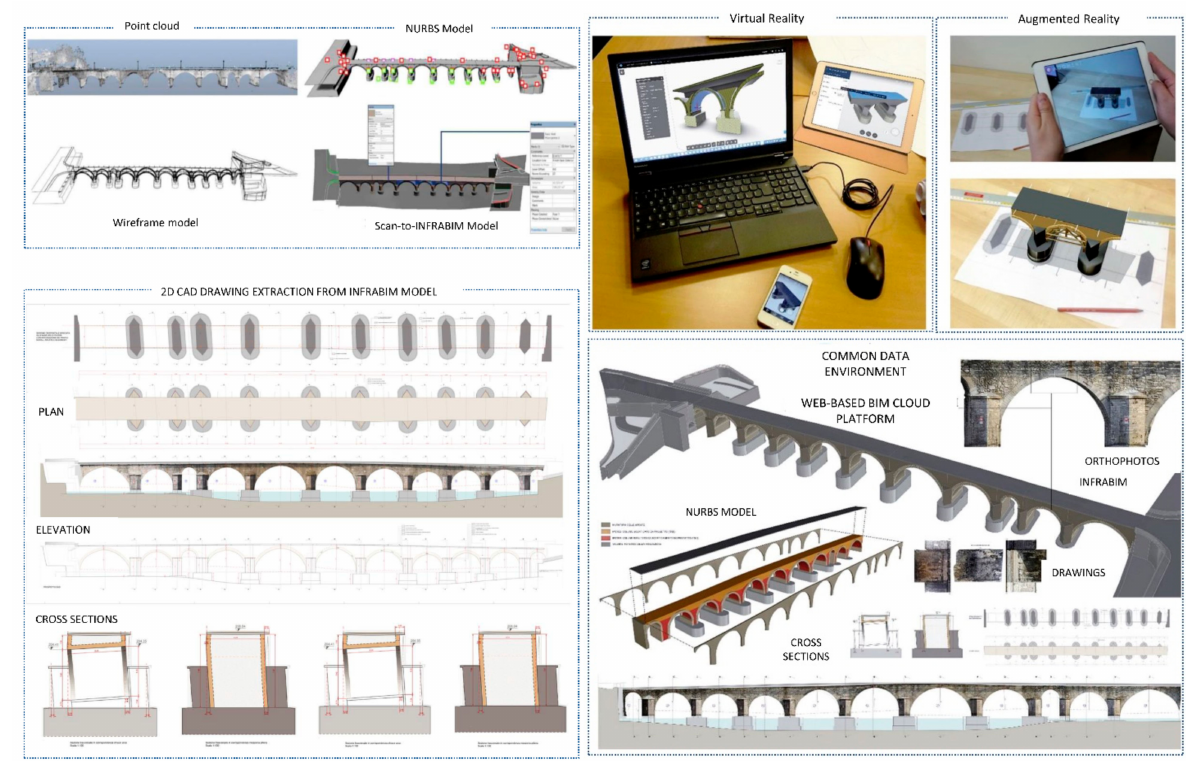
Figure 15. Azzone Visconti Bridge drawings, HBIM objects, geometric analysis, cloud and AR